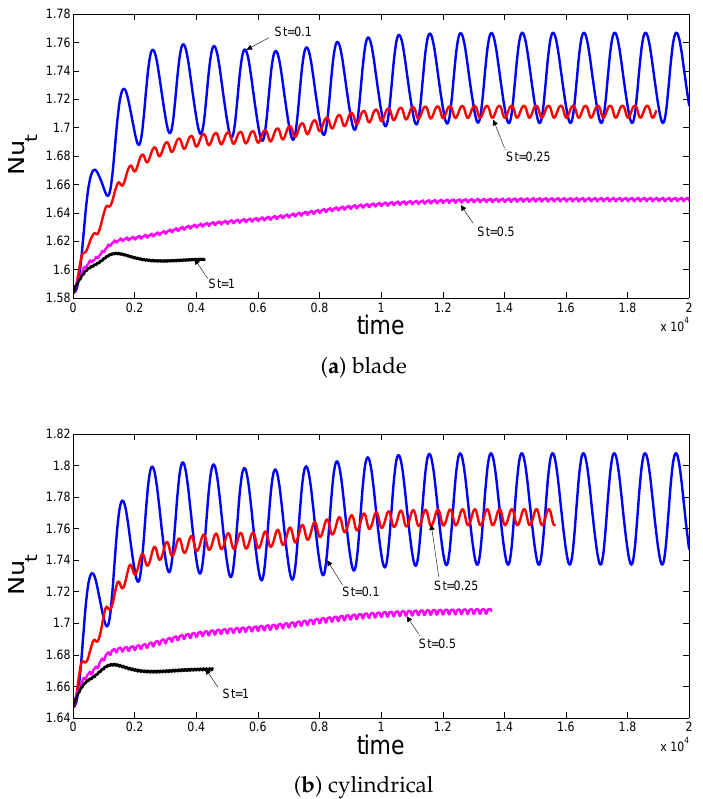
Figure 11. The effects of the Strouhal number on the spatially-averaged Nusselt number along the hot wall for the blade and cylindrical particle shapes with φ = 0.02.